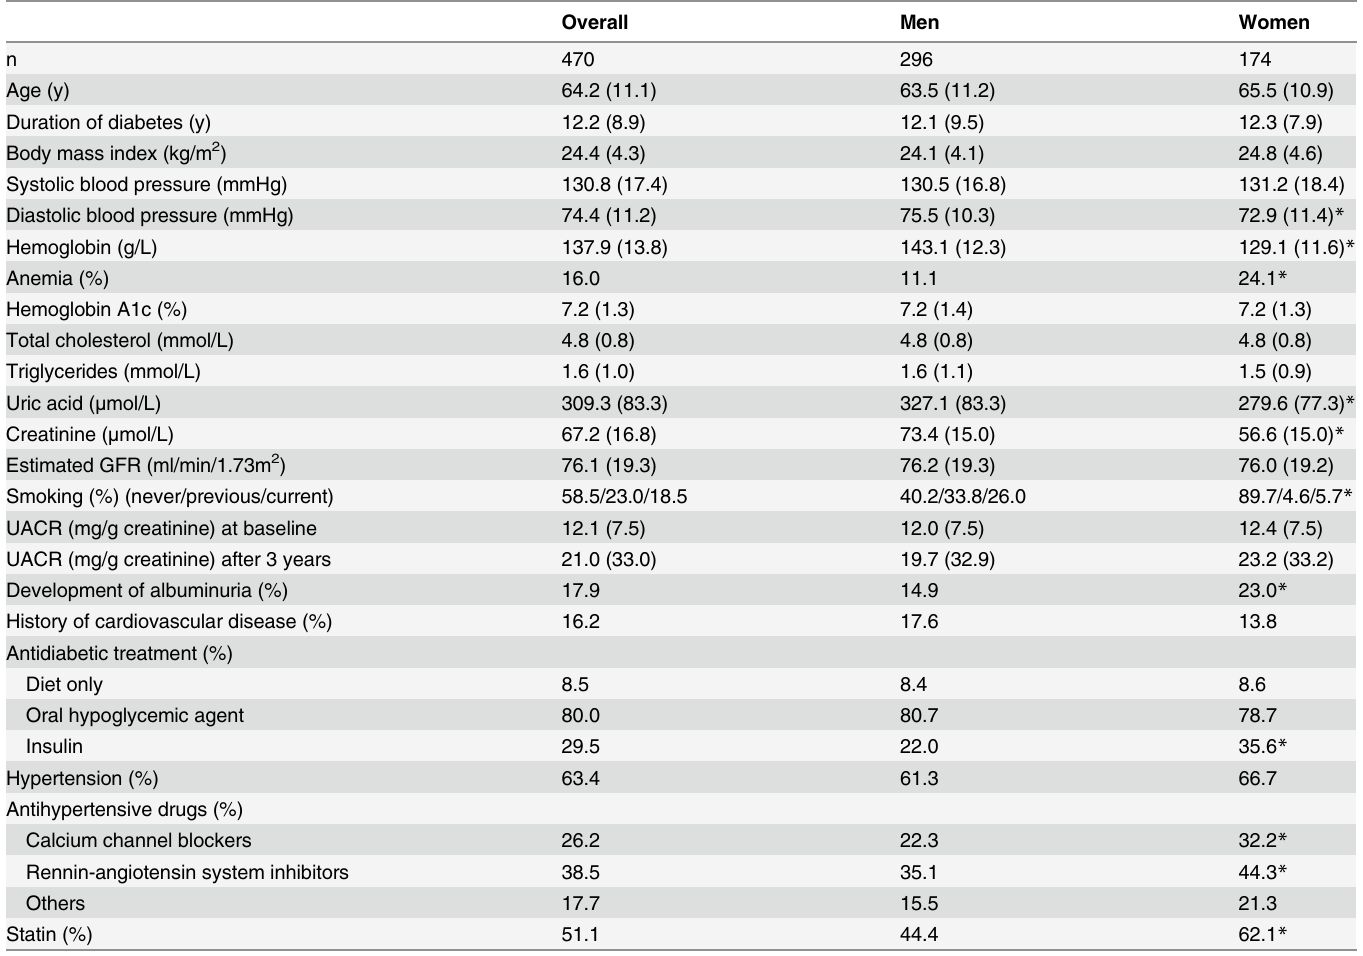
Table 1. Characteristics of patients at